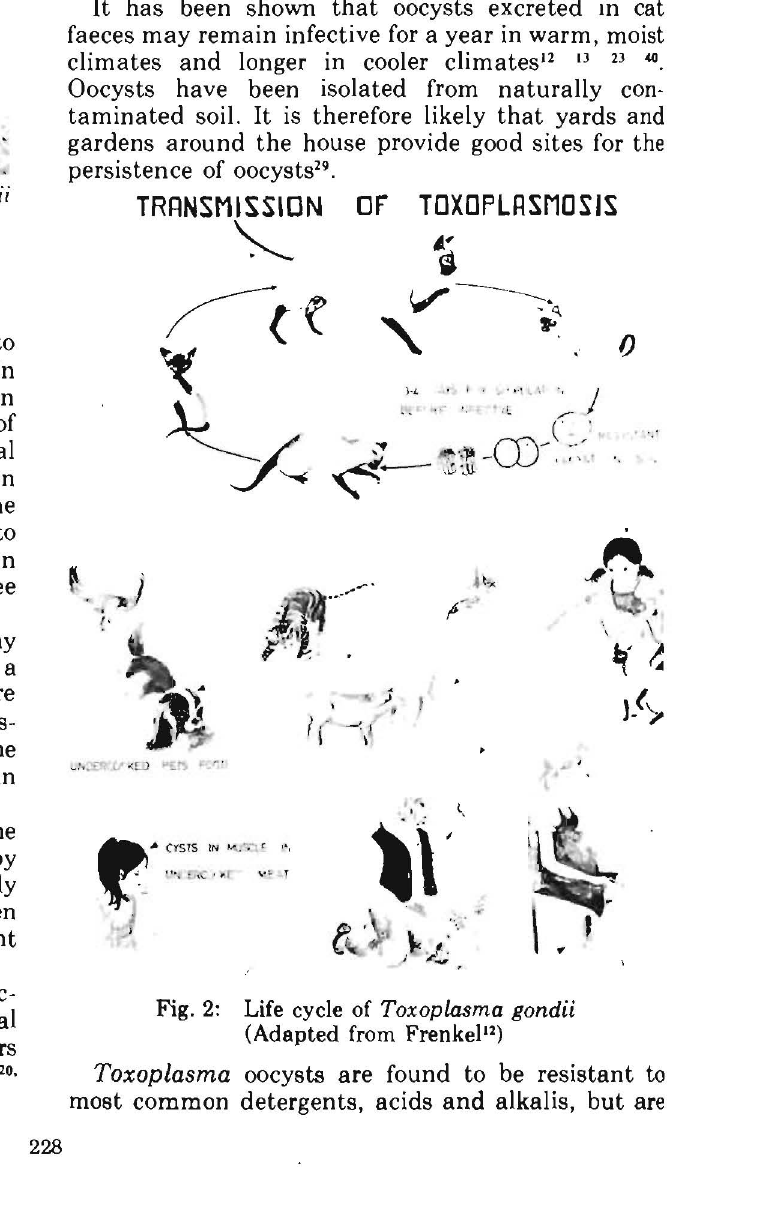
Fig. 1: Oocysts of Isospora felis (a) and Toxoplasma gondii (b) x 1 500 (Kind permission J W Plant et a/2 6) Extra-intestinal (tissue) cycle: These stages, which also occur in cats, appear to of sporulated oocysts of feline origin or the ingestion of tissue cysts containing bradyzoites or transplacental infection of the foetus with tachyzoites after ingestion of encysted bradyzoites or sporulated oocysts by the pregnant female. Tachyzoites then spread from cell to cell and are disseminated to various organs in macrophages, lymphocytes, granulocytes and in free forms in the circulation 12 16 19.